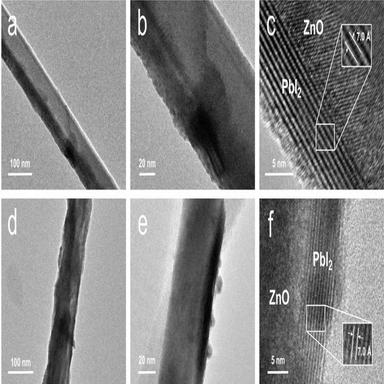
X-ray diffraction patterns of (a) ZnOePbI2 NW arrays on Si/SiO2 substrate made using the thermal evaporation approach; (b) ZnOePbI2 NW arrays on Si/SiO2 substrate made by converting the magnetron-sputtered lead oxide coating; (c) PbI2 thin film made by converting a lead oxide film.